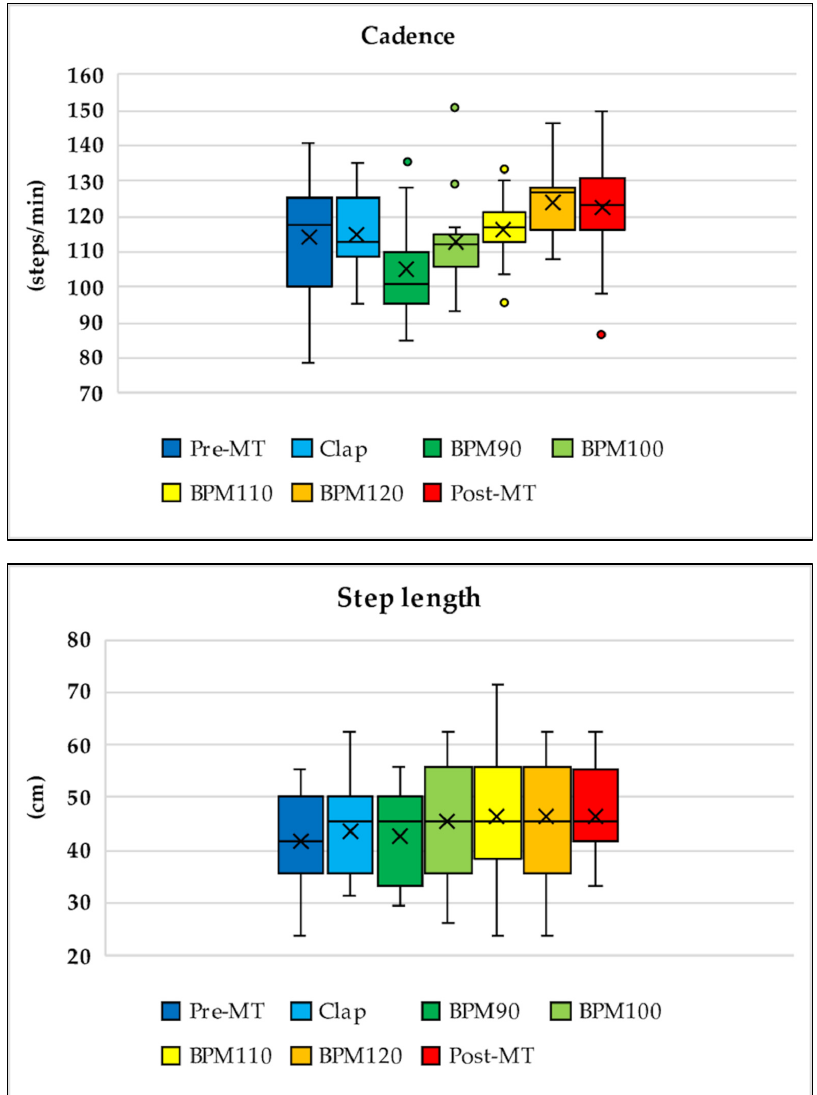
Figure 4. Transition throughout the entire walking task for acceleration, gait speed, cadence, and step length. During transitions in the walking tasks with music (from Tasks 3 to 6), values of acceleration, gait speed, cadence, and step length increased gradually. The best improvement was observed in Task 6 (music at 120 beats per minute (BPM)) and remained in Task 7 even without music. Walking speed in Task 3 (music at 90 BPM) was slightly slower than that in Task 2 (hand clapping while walking at the subjects’ own pace).